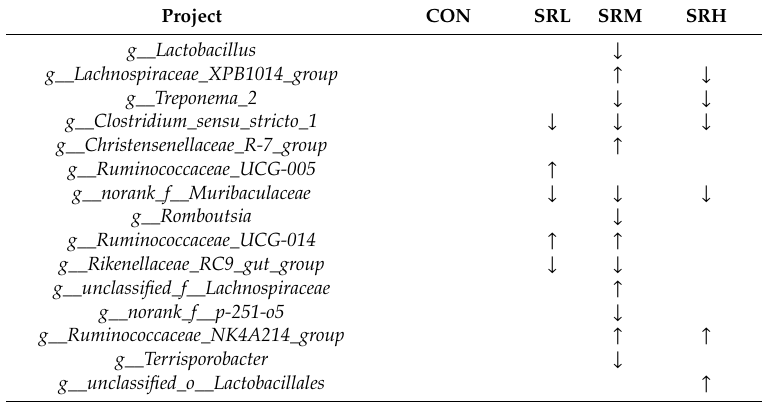
Table 7. Comparison of changes in genus with significant di ff erences in each